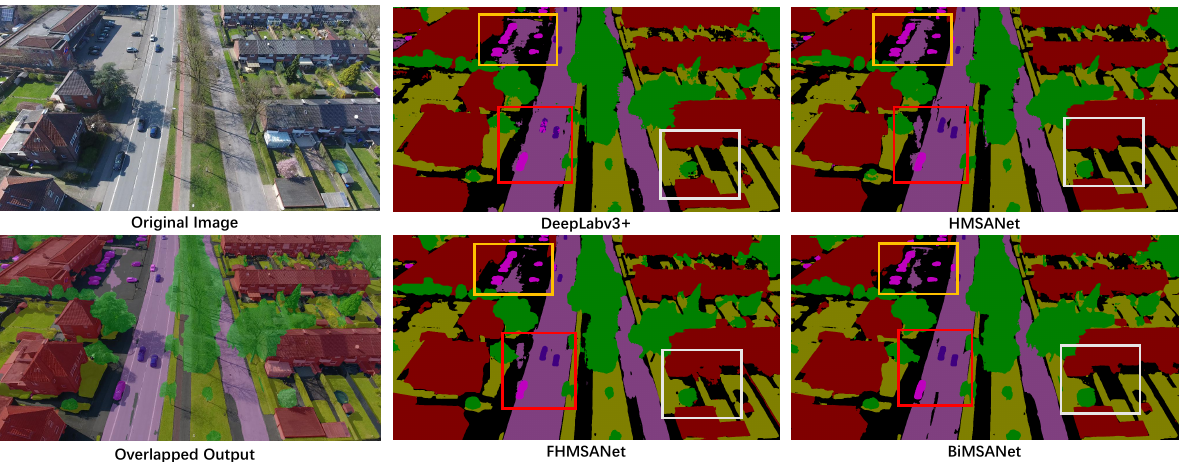
Figure 6. Qualitative comparisons of different models on the UAVid2020 test set. The example image is from the test set (seq30, 000400). Bottom left image shows the overlapped result of the BiMSANet output and the original image. Three example regions for comparisons are marked in red, orange, and white